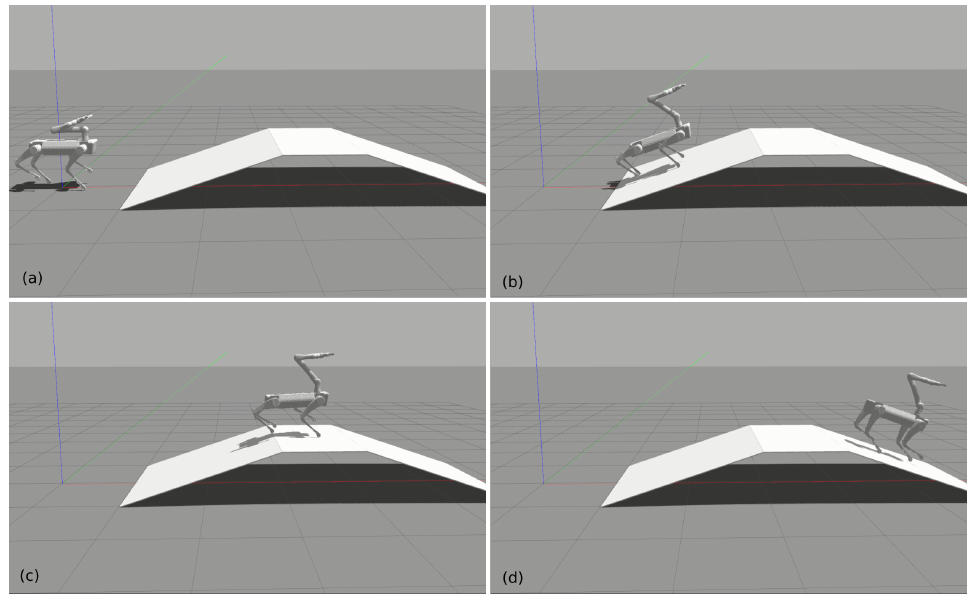
Figure 7. Trotting up and down a 20-degree slope while moving the arm. ( a ) The initial position.